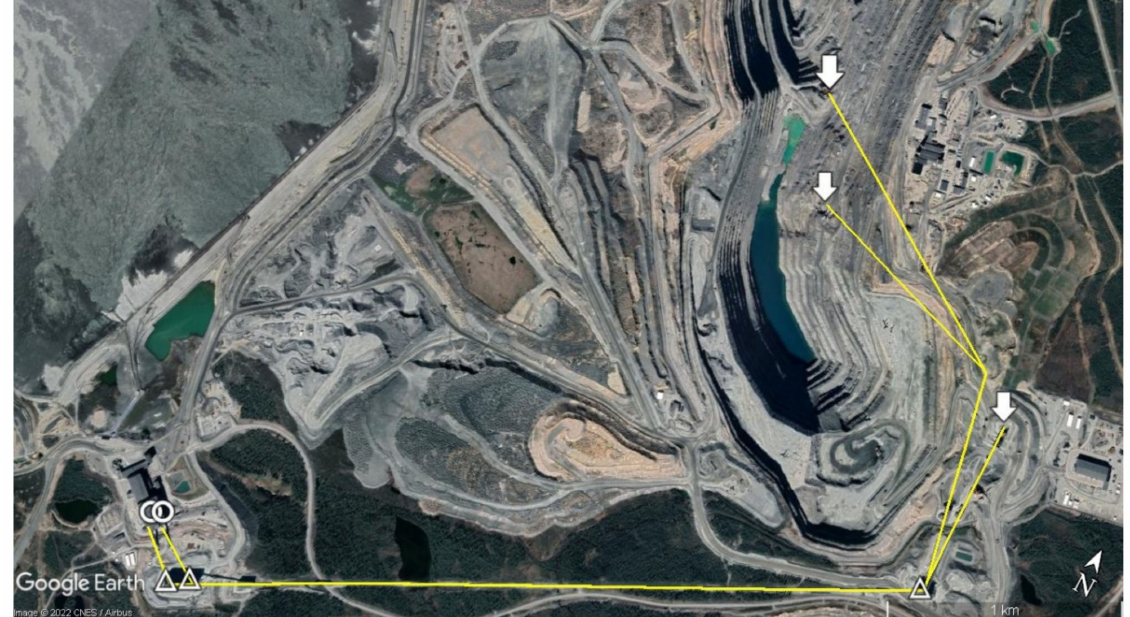
Figure 1. Overview of the southeast part of the mine, with the crushers, stockpiles, and the mills marked with white arrows, triangles, and circles, respectively. The yellow line shows the approximate trace of the conveyors. Created with Google Earth Pro.